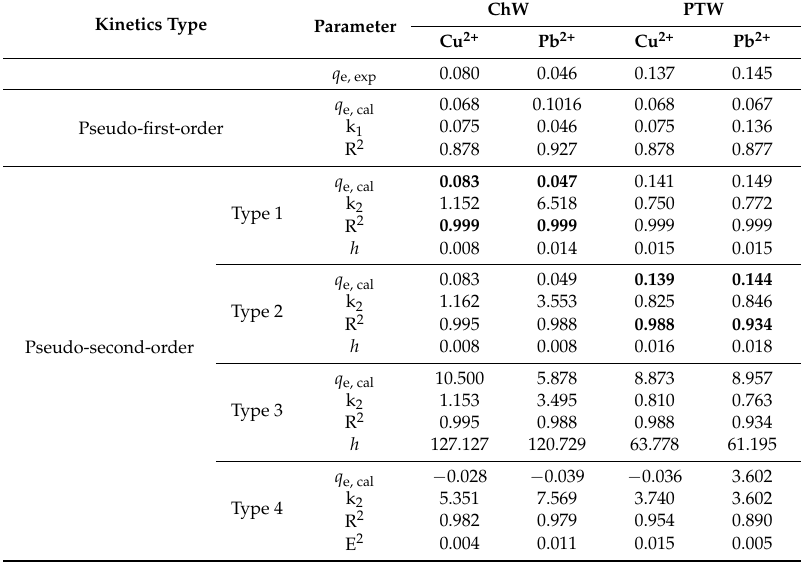
Table 4. The parameters for pseudo-first-order and types 1–4 of